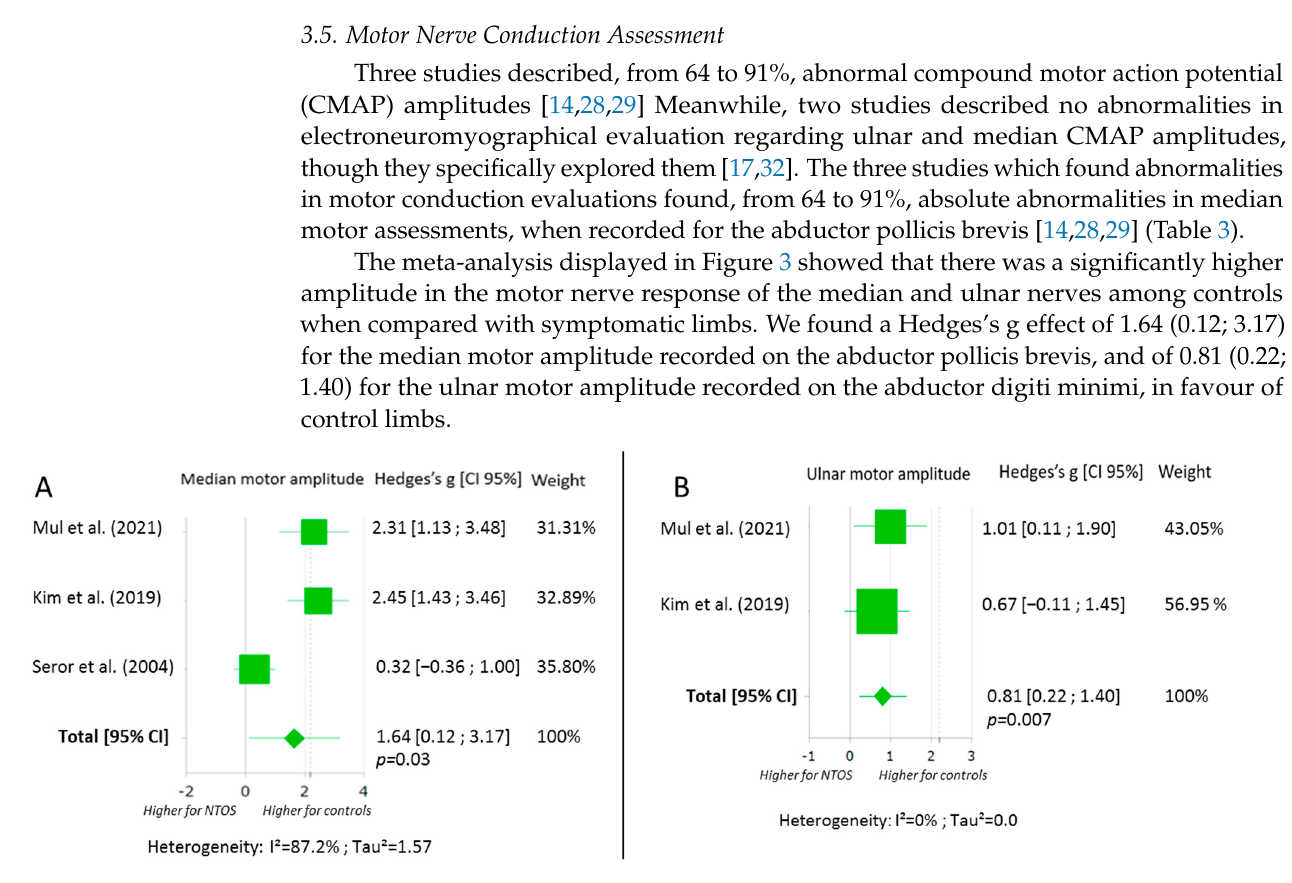
Table 4. Percentage of abnormal needle electromyographies per muscle.